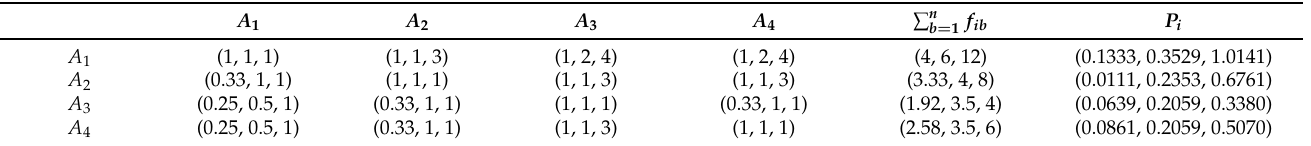
Table 5. The fuzzy matrix F and the the fuzzy synthetic extent of the each category P i